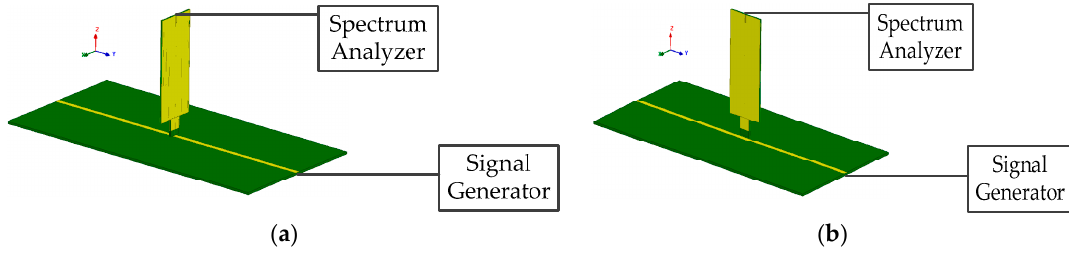
Figure 15. Configuration of the H-field rejection measurement. ( a ) Electric-field coupling and ( b ) magnetic-field coupling. The outputting power of the signal generator is 0 dBm.